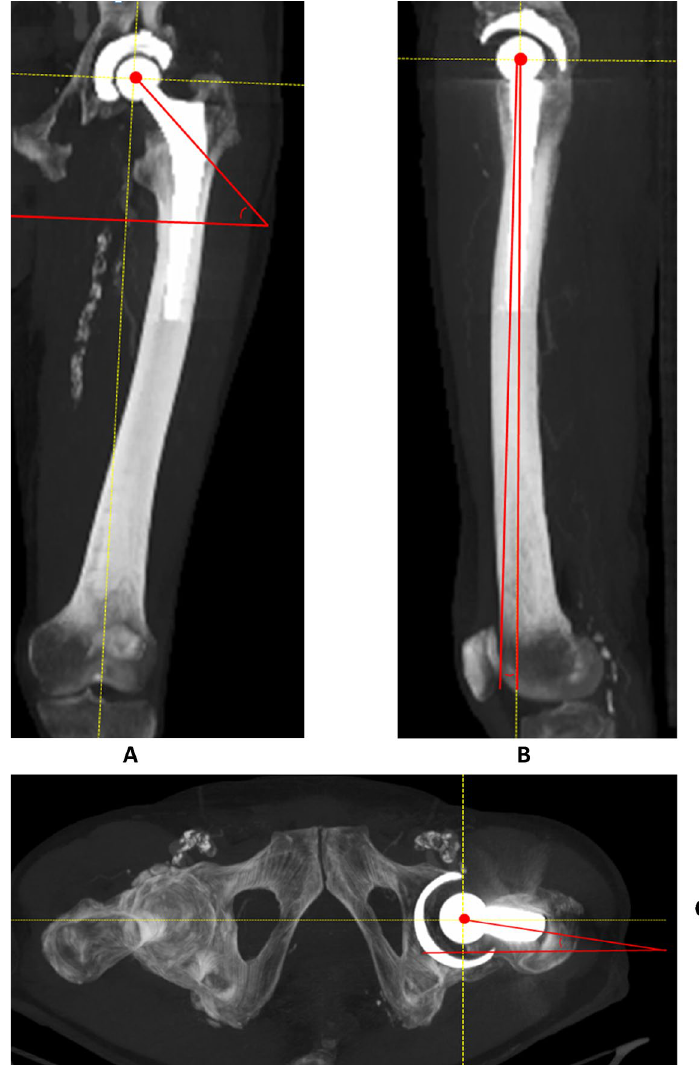
Figure 2. Measurement method of coronal inclination (CI F’ , defined as the angle between the line through the longitudinal axis of the neck of the femoral component and the horizontal on the mechanical femoral axis) ( a ), sagittal inclination (SI F’ defined as the angle between the line from the center of the femoral head to through the middle of the femoral neck, in relation to the mechanical femoral axis) ( b ) and transverse version (TV F’ , defined as the angle from the center of the femoral head through the femoral neck, in relation to the horizontal on the mechanical femoral axis, with the posterior condylar plane as distal reference) ( c ) of the femoral component on 3-D MIP constructed CT (mechanical femoral axis/horizontal displayed as dashed